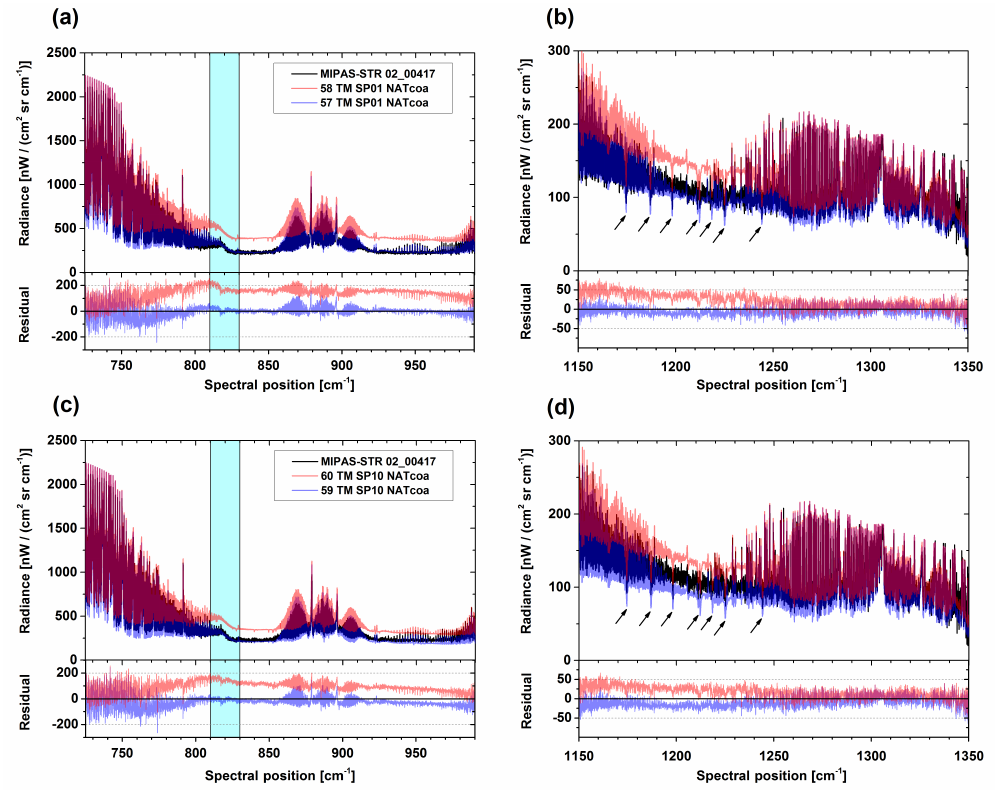
Figure 12. T-Matrix calculations for highly aspherical β -NAT particles. Black spectra in all panels: MIPAS-STR limb observation (13:47UTC, tangent altitude 18.4km). Simulations of β -NAT with (a, b) AR = 0.1 and (c, d) AR = 10.0 with size distributions A (red) and B (blue). Lower panels: residuals between the simulations and the observation. Black arrows denote prominent H 2 O absorption signa- tures from scattering of tropospheric radiation by PSC particles. Numbers in the legend refer to scenarios in Table 1. “NATcoa” corresponds to β -NAT, “TM” to T-matrix simulation, and “SP” to spheroid (numbers indicate